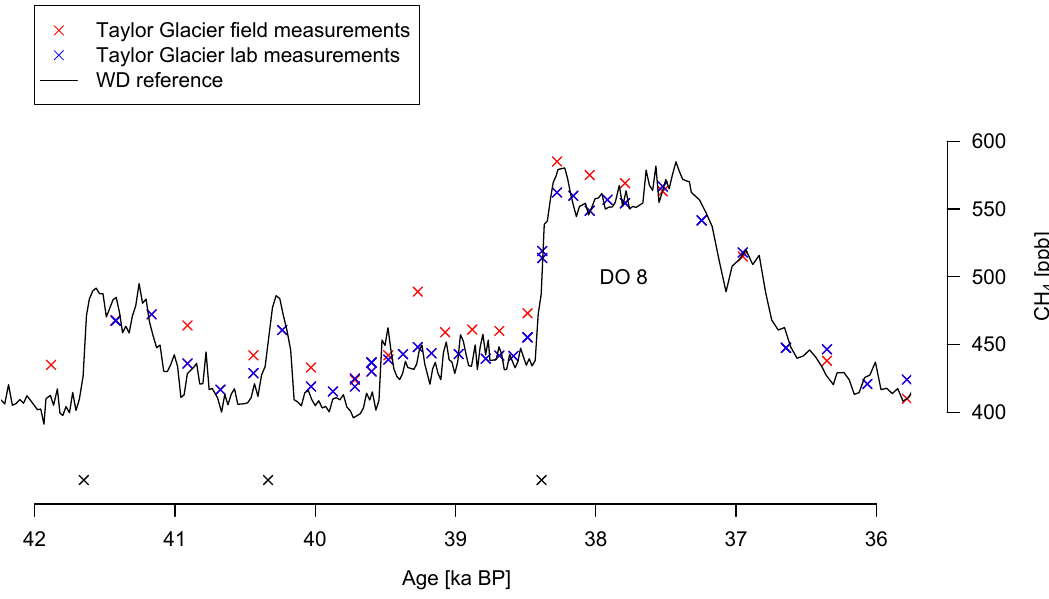
Figure A1. Methane data from Taylor Glacier field analyses (red crosses), lab analyses (blue crosses), and the WD reference record (black line) for a well-sampled time period during MIS 3 including Dansgaard–Oeschger (DO) event 8. Black crosses on the bottom of the plot show fixed tie points used in the WAIS Divide–Taylor Glacier synchronization (Table